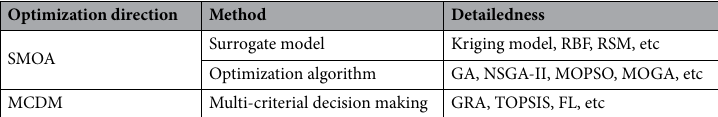
Table 1. The methods of multi-objective